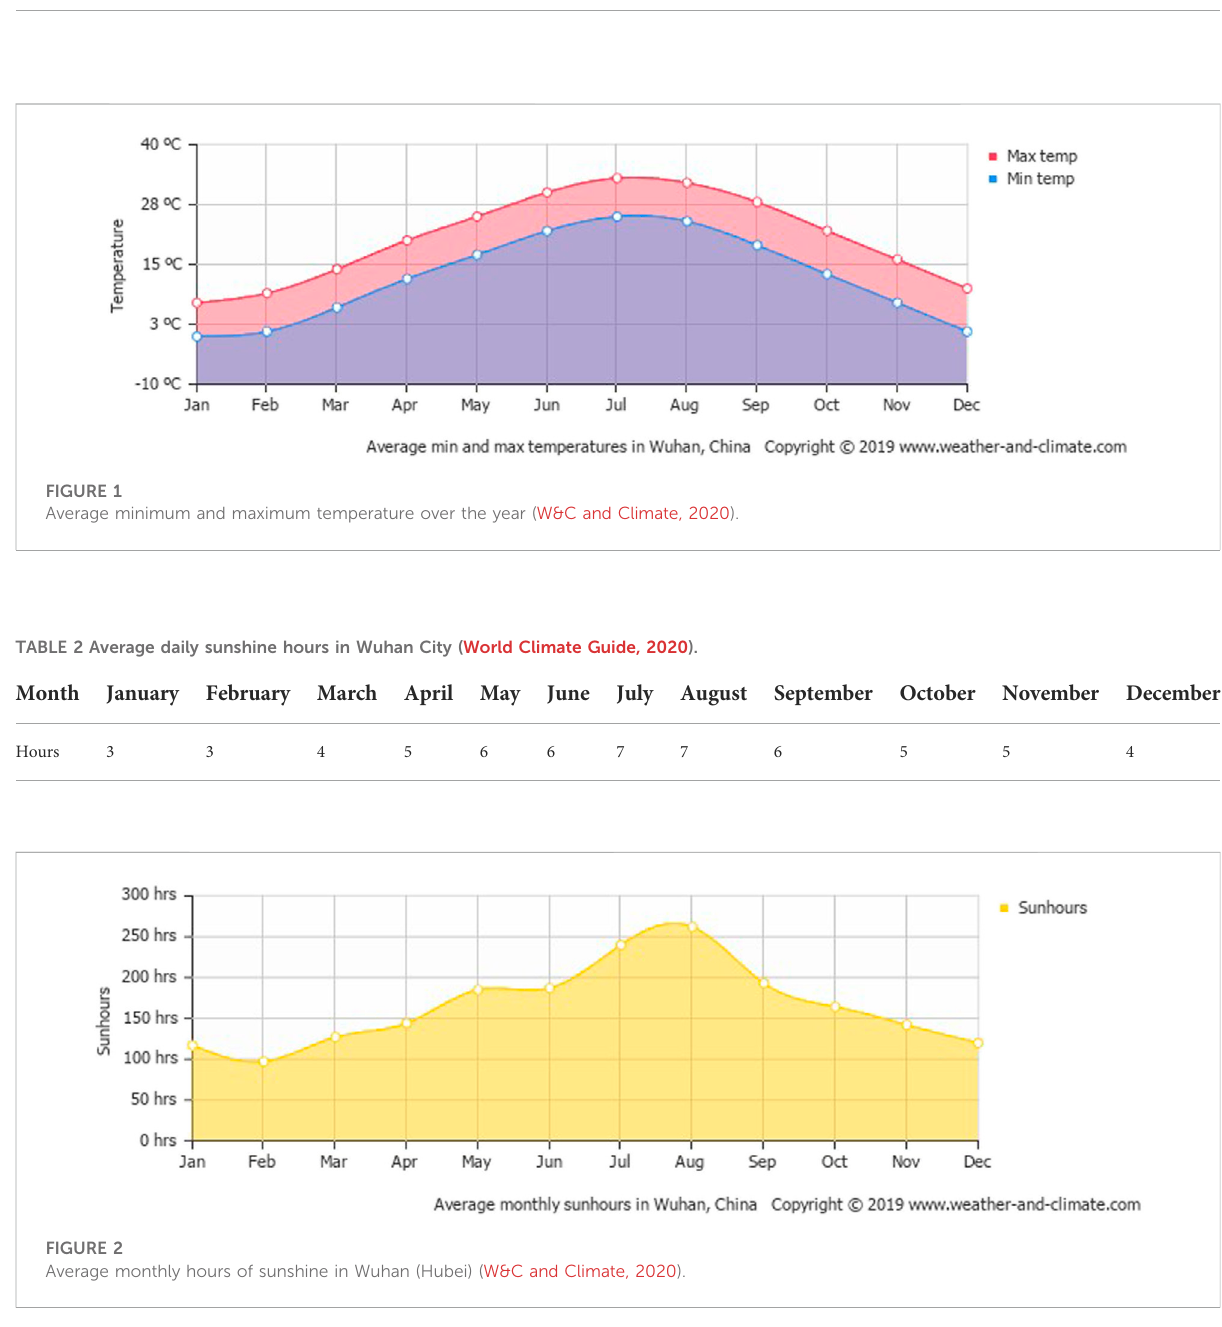
Frontiers in Built